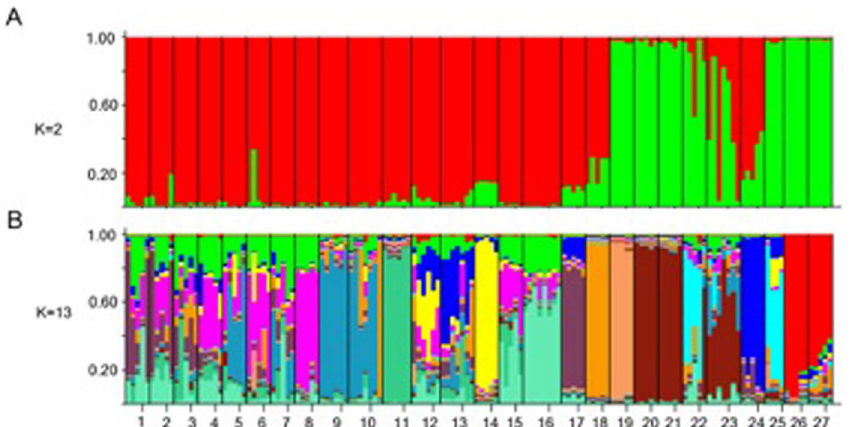
Figure 2. Population structure of C.emmae assessed by multilocus genotype clustering by Structure. Each colony is represented by a small vertical bar. (A) population structure following Evanno et al 2005 (K=2). (B) Population structure following the estimated logarithmic probability of the data ln P(D/K) being explained (K=13). Nest codes (27) start from 1 at Agrd Noudoz (Northwest) and continue increasing numerically to 25 in Skoura (Northeast) and 26–27 at Tamnougalt (Southeast).